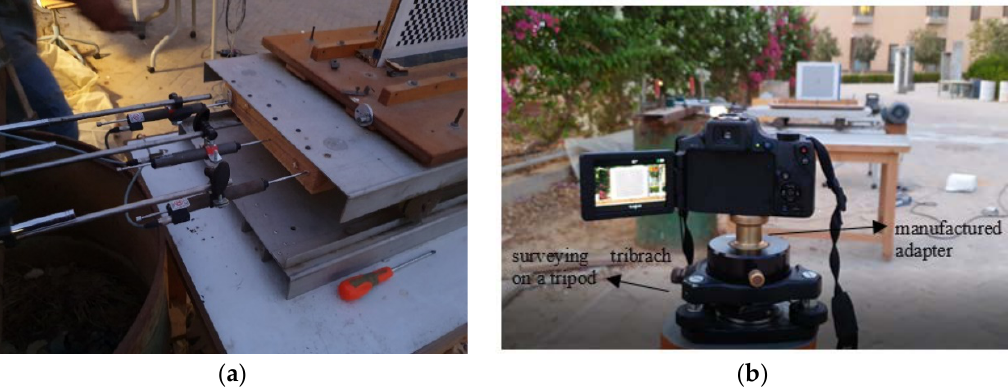
Figure 11. ( a ) Three LVDTs attached to the shaking table and ( b ) monitoring the shaking table from the first station.